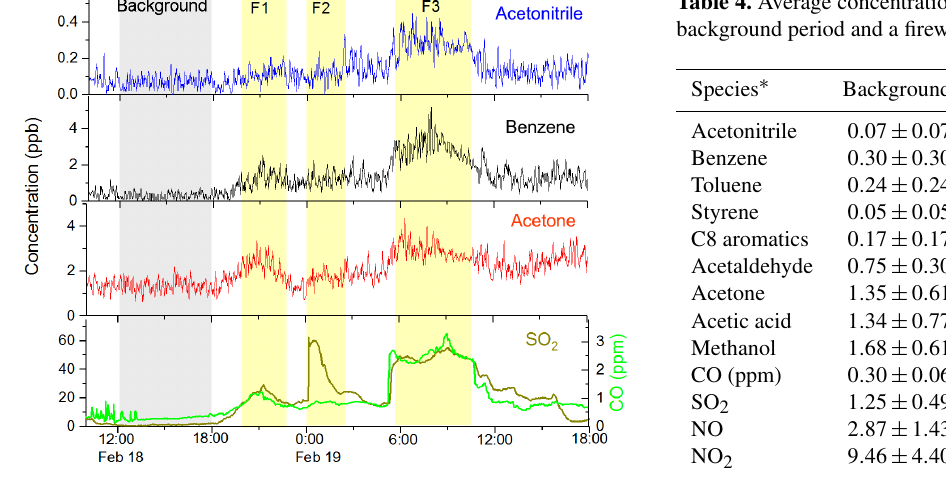
Figure 10. Time series of acetonitrile, benzene, acetone, SO 2 , and CO during the CNY festival. F1, F2, and F3 represent three firework episodes.